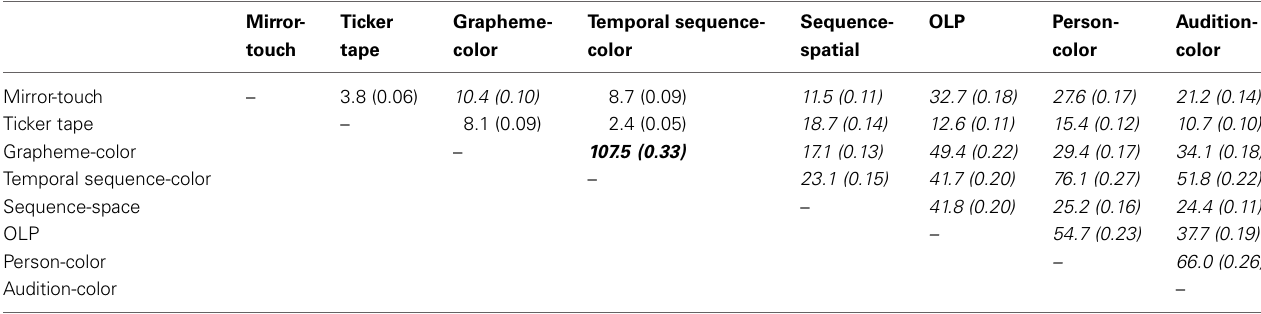
Table 2 | Co-occurences among subtypes of synesthesia and phenomenal traits, displayed using Pearson χ 2 values; phi ( (cid:2) ) effect sizes in